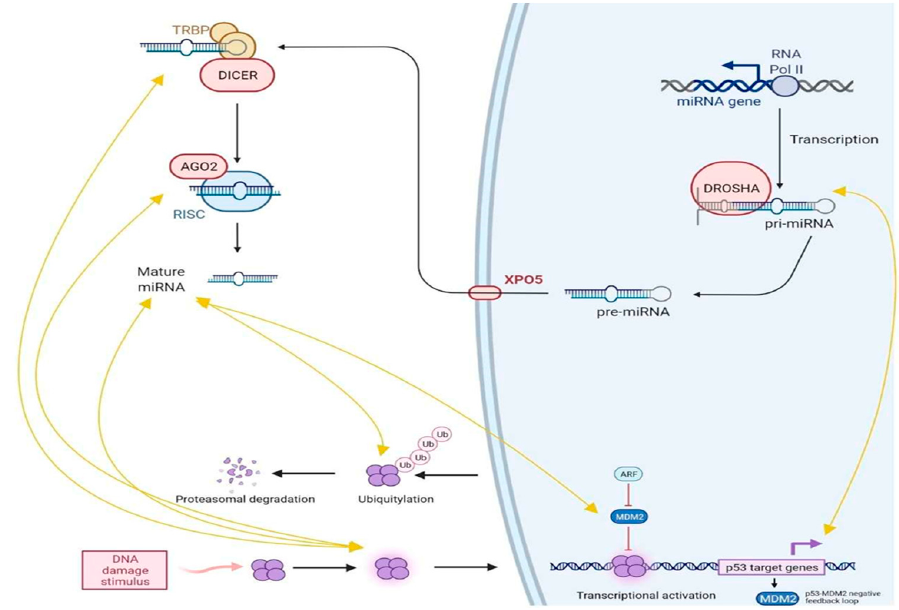
Figure 6. Crosstalk between p53 and miRNAs (see text for details).